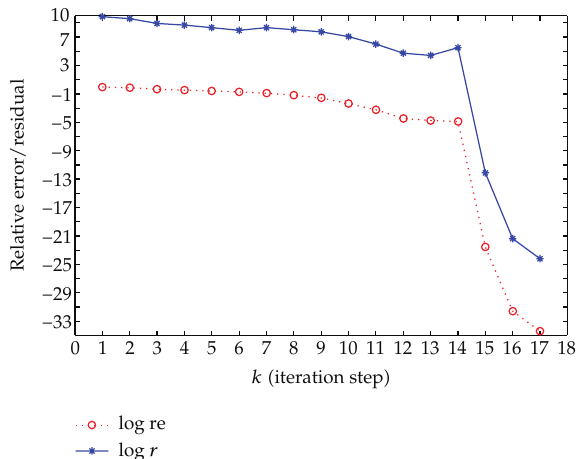
Figure 4: The relative error of the solution and the residual for Example